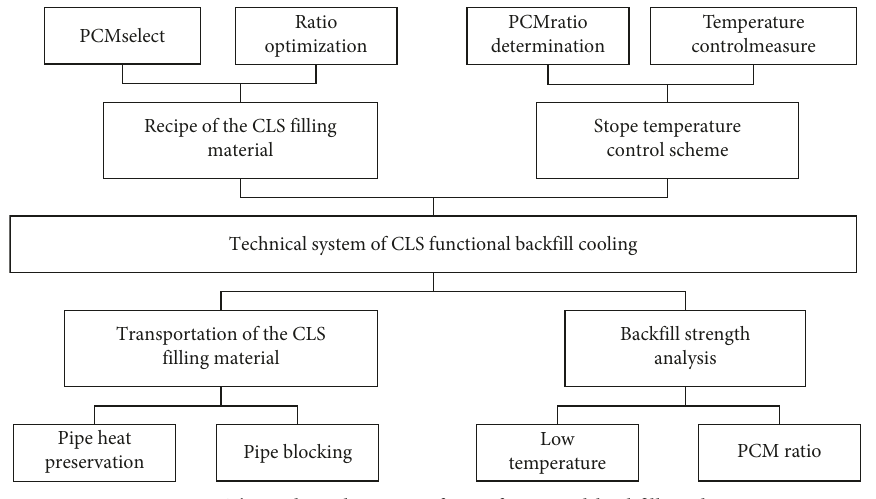
Figure 4: The technical system of CLS functional backfill